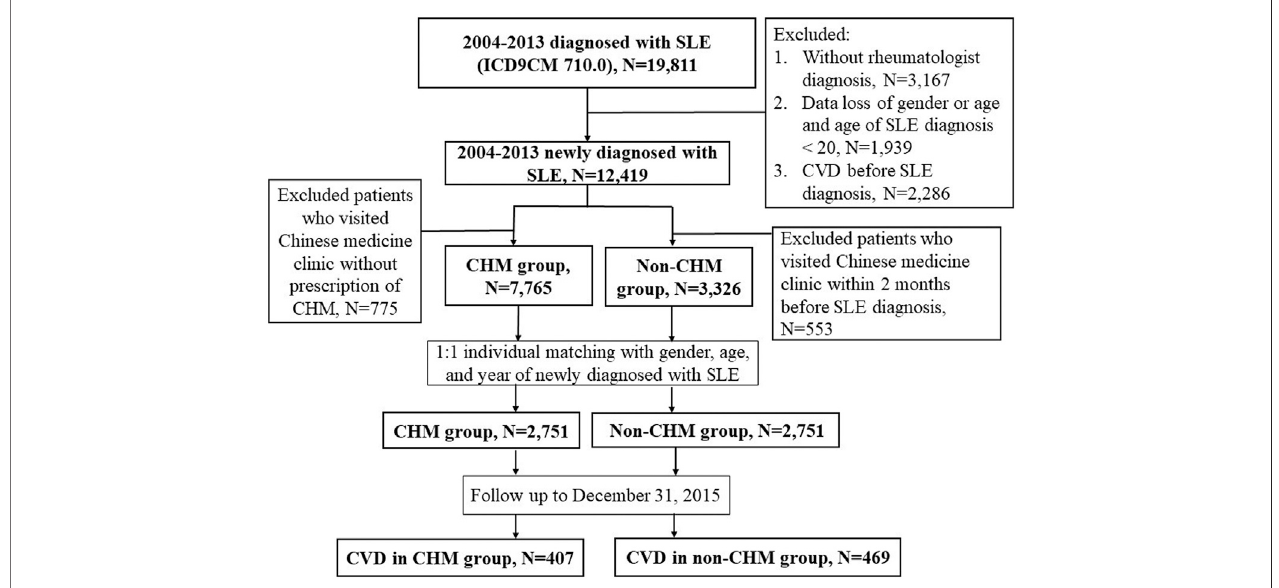
FIGURE 1 | Flowchart of the study. SLE, systemic lupus erythematosus; ICD-9-CM, International Classi fi cation of Disease, Ninth Revision, Clinical Modi fi cation; CVD, cardiovascular disease; CHM, Chinese herbal medicine.